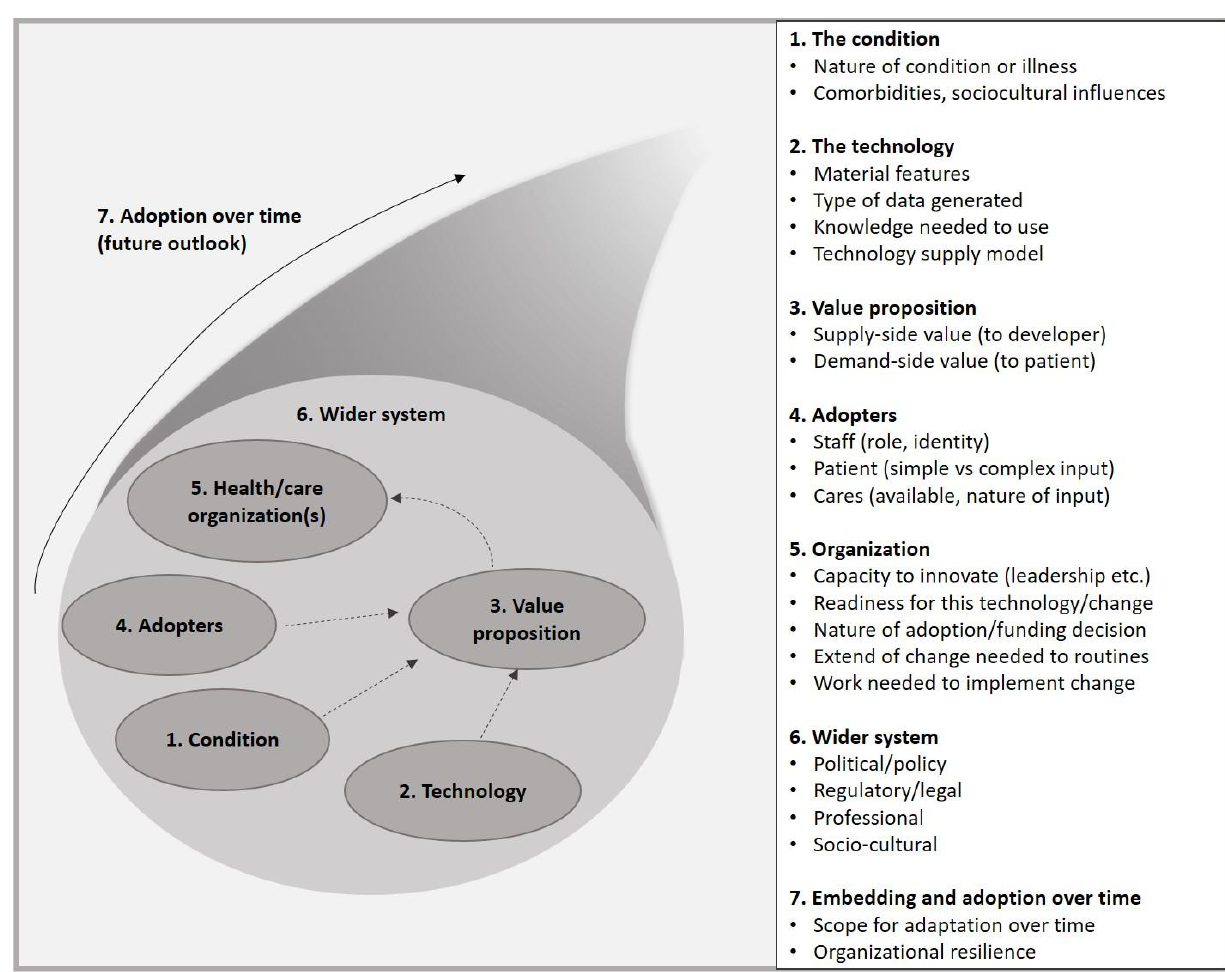
Figure 1. NASSS (Non-adoption, Abandonments, Scale-Up, Spread, and Sustainability) frame-